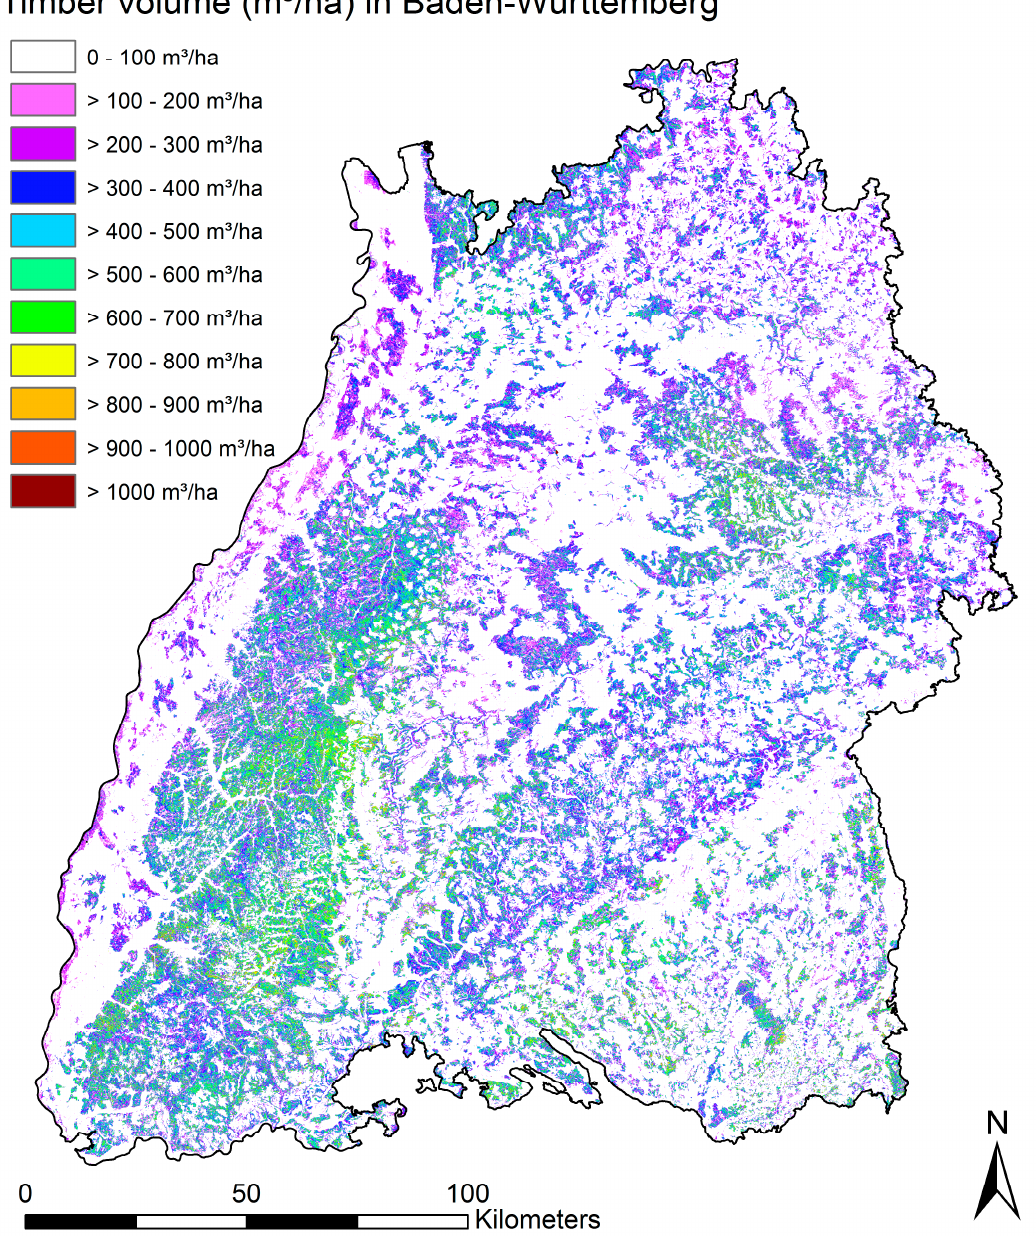
Figure A2. Map of timber volume Figure B2. Map of timber volume predictions.